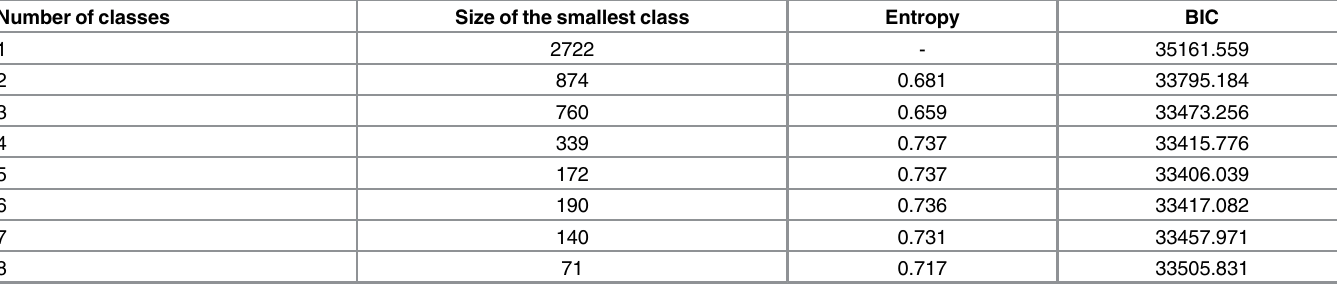
Table 4. Characteristics of the 1 – 8 class latent class analysis